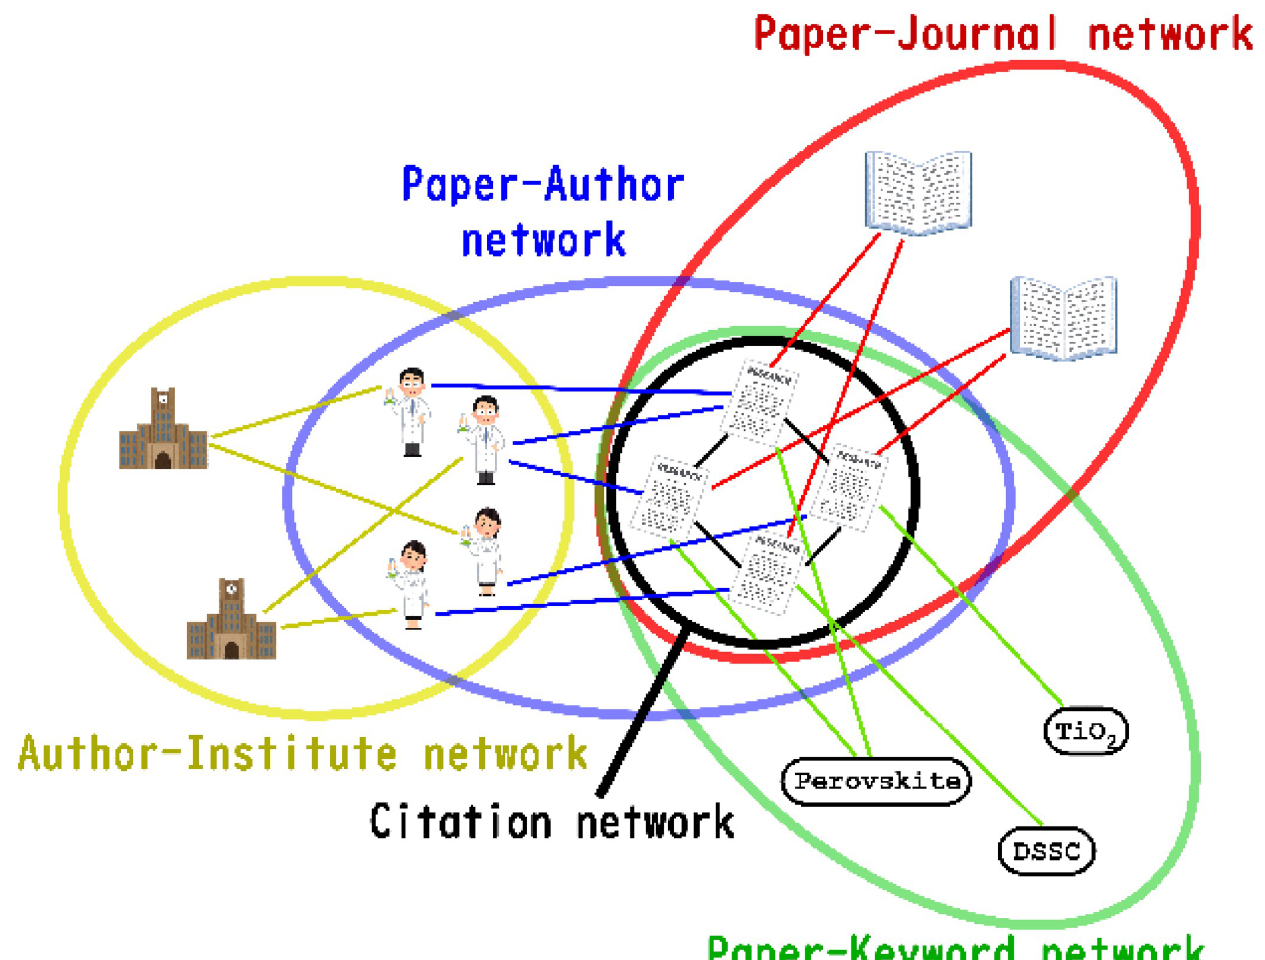
Fig 2. Outline of a heterogeneous network to be